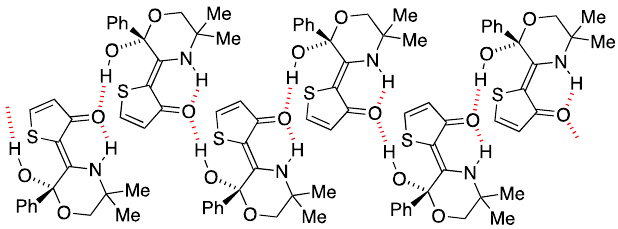
Figure 2. Schematic representation of the hydrogen bonding pattern for 20. Table 1. Hydrogen bonding parameters for 20 (Å, °).